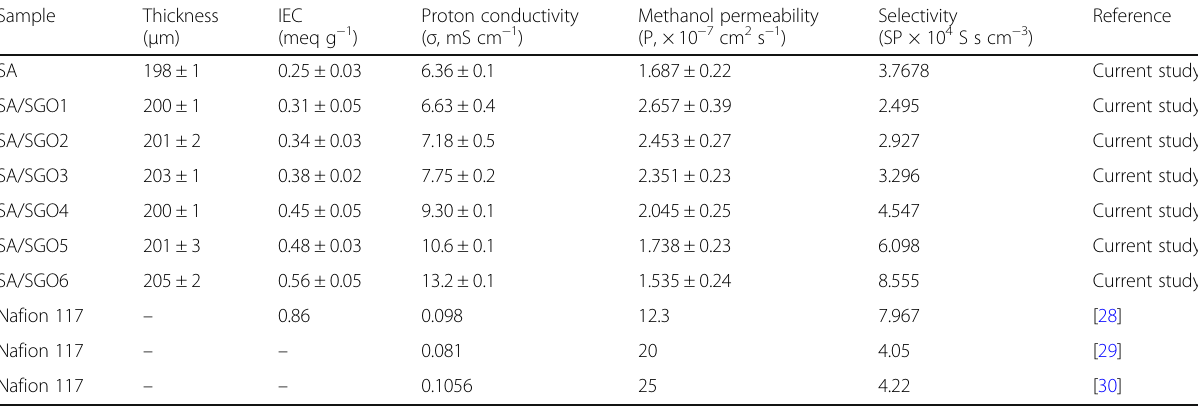
Table 1 Thickness, IEC, proton conductivity, methanol permeability, and membrane selectivity of SA/SGO composite biomembrane with different SGO content